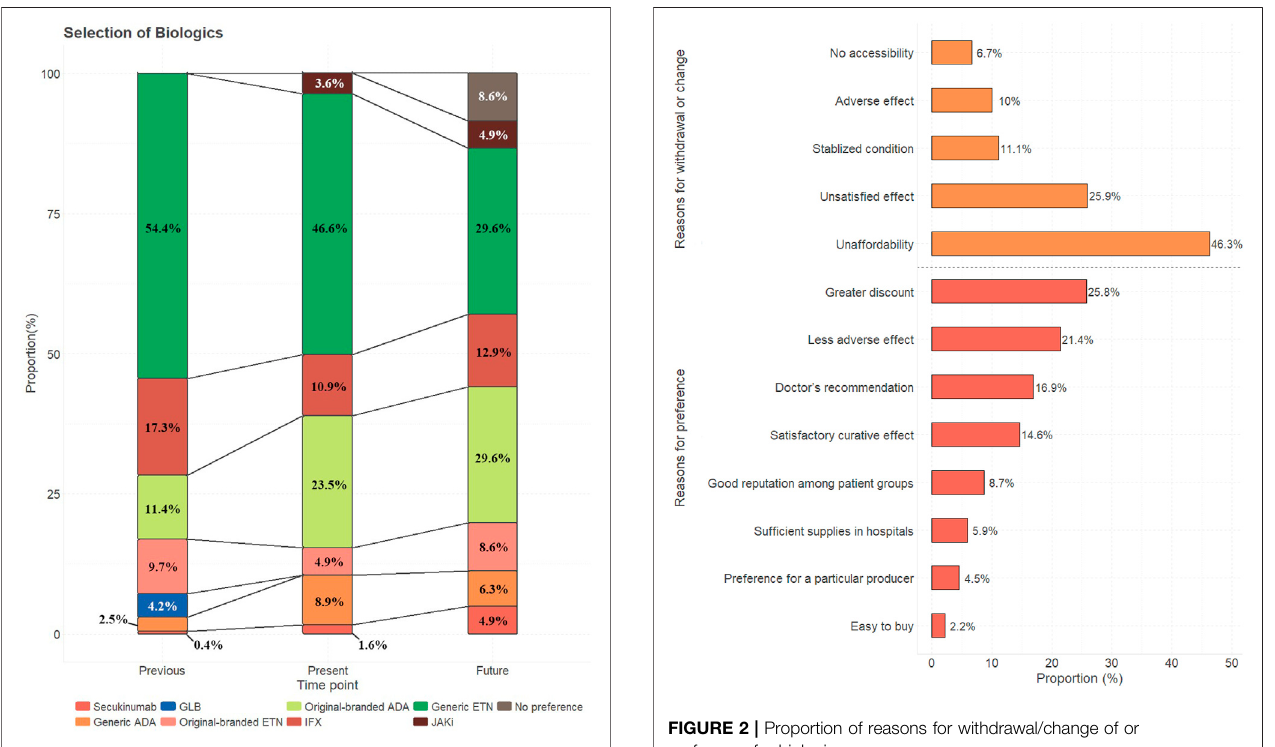
FIGURE 1 | Choice or preference of biologics in different time points.